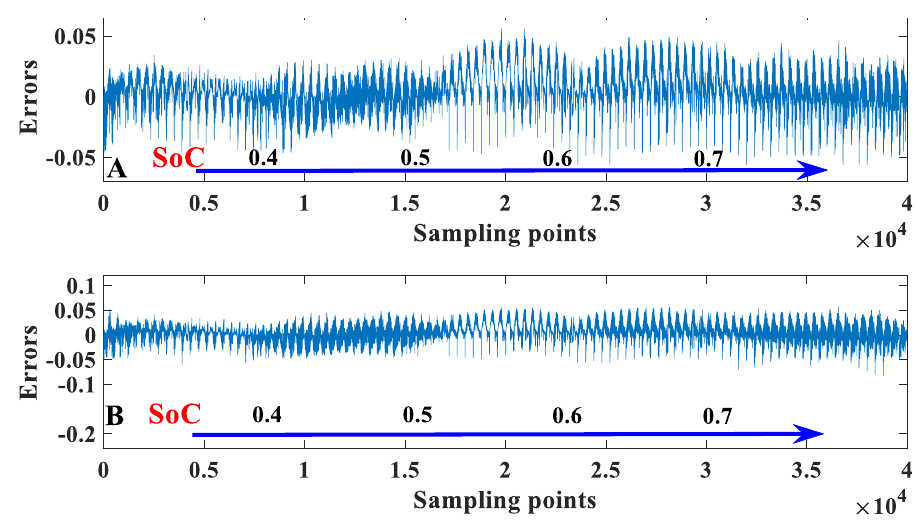
Figure 9. SoH estimation results under different SoC errors when reference SoC = 0.5.